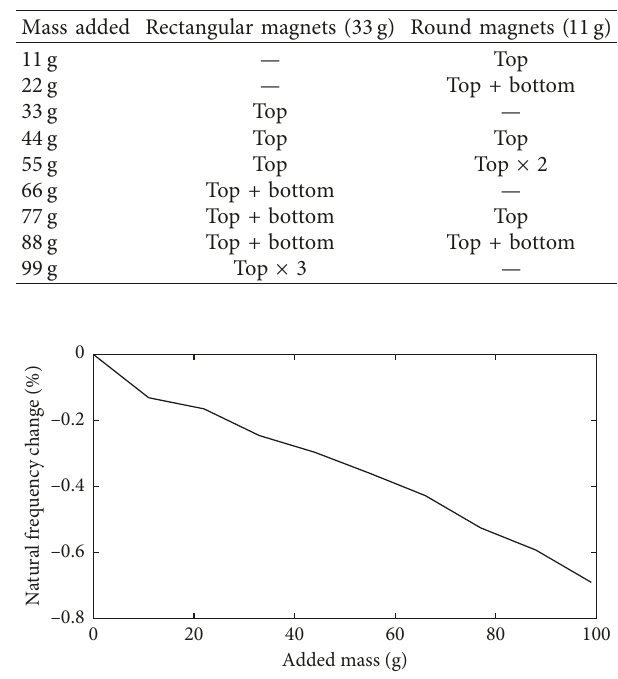
Figure 5: The change in the experimental natural frequency due to mass